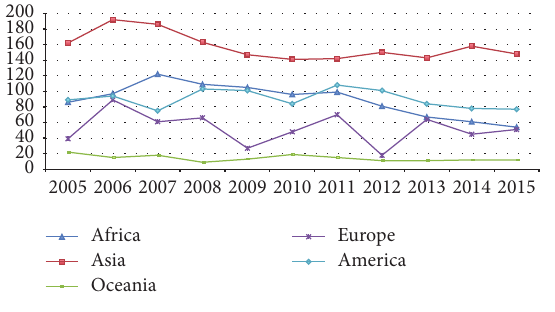
Figure 2: Number of natural disasters in the world from 2005 to 2015.